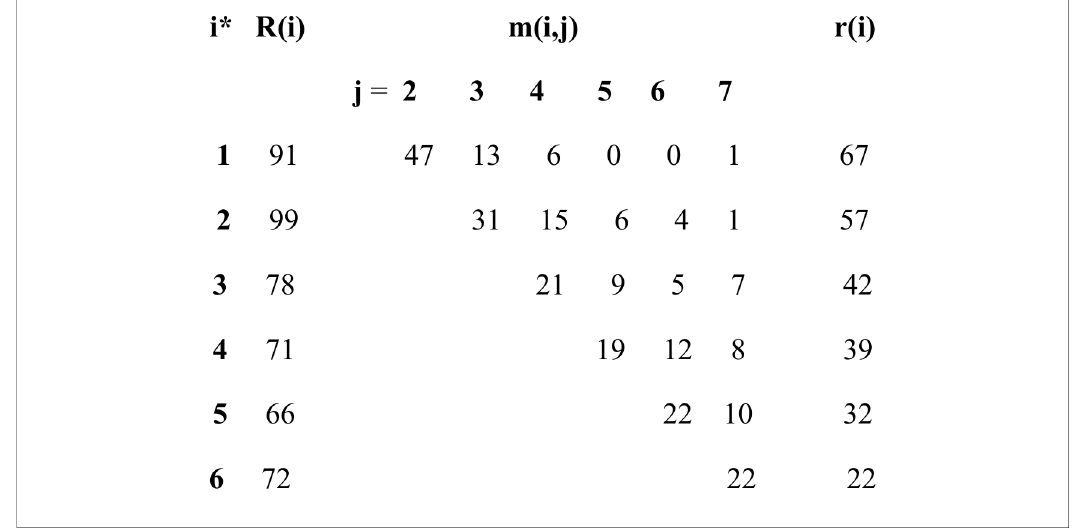
Fig 2. Number of dogs releasedin each capture and recapturedin the subsequent efforts of captures. * i = capture effort; R = number of animalsreleased alive just after a capture; r = total of animalsreleasedand recaptured at least once; mij: number of animalsrecaptured for the first time subsequent to a specific effort i.